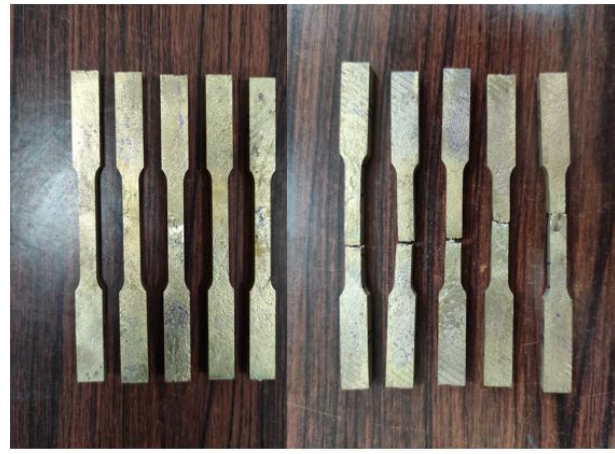
Figure 12. Tensile specimen before and after tensile test.